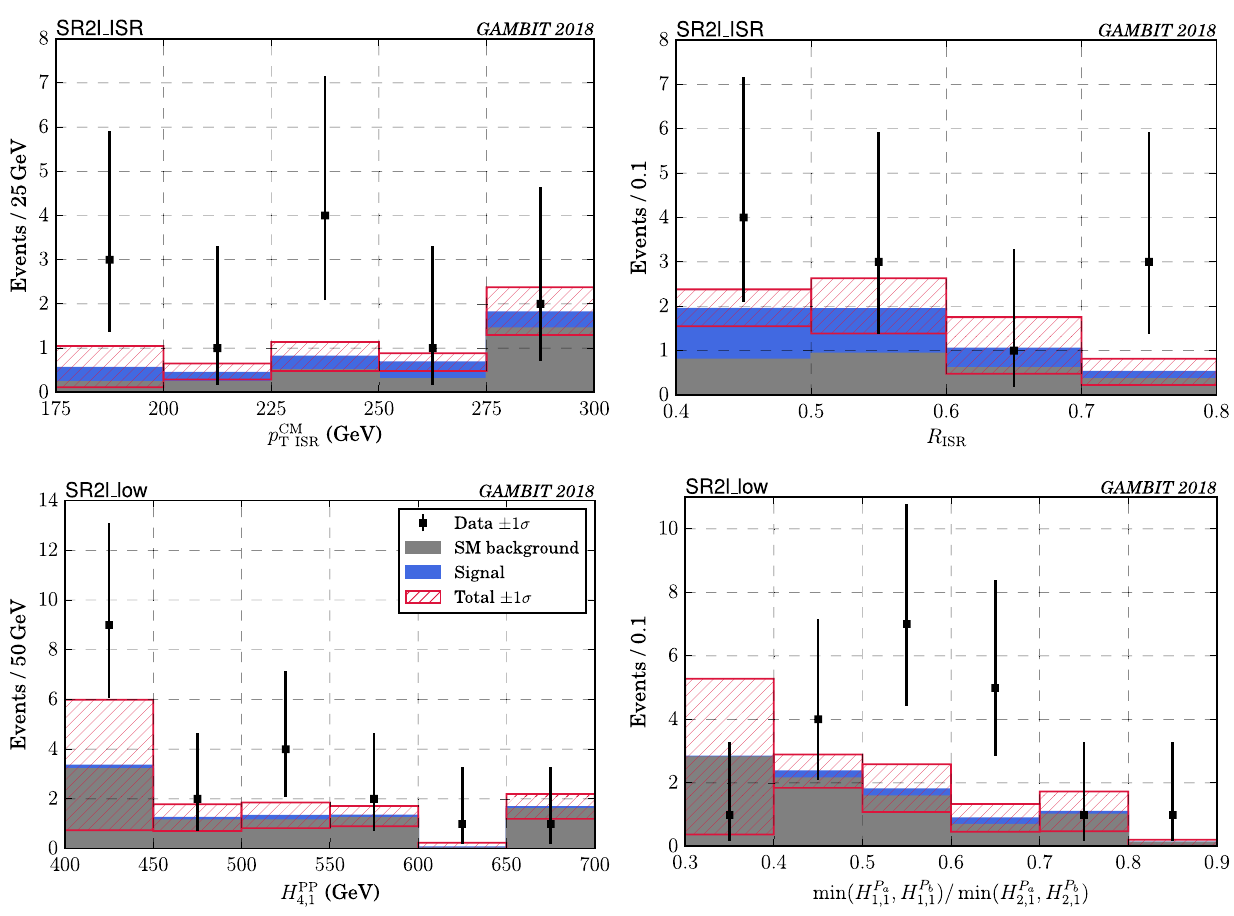
Fig. 22 Distribution of kinematic variables in the 2 lepton signal regions for the ATLAS RJ analysis, after applying all selection require- ments. The grey bars show the total SM background (taken from Ref. [117]) and the stacked blue bars show the signal for our best-fit point based on the combination of 8 and 13TeV data. The hatched red bands